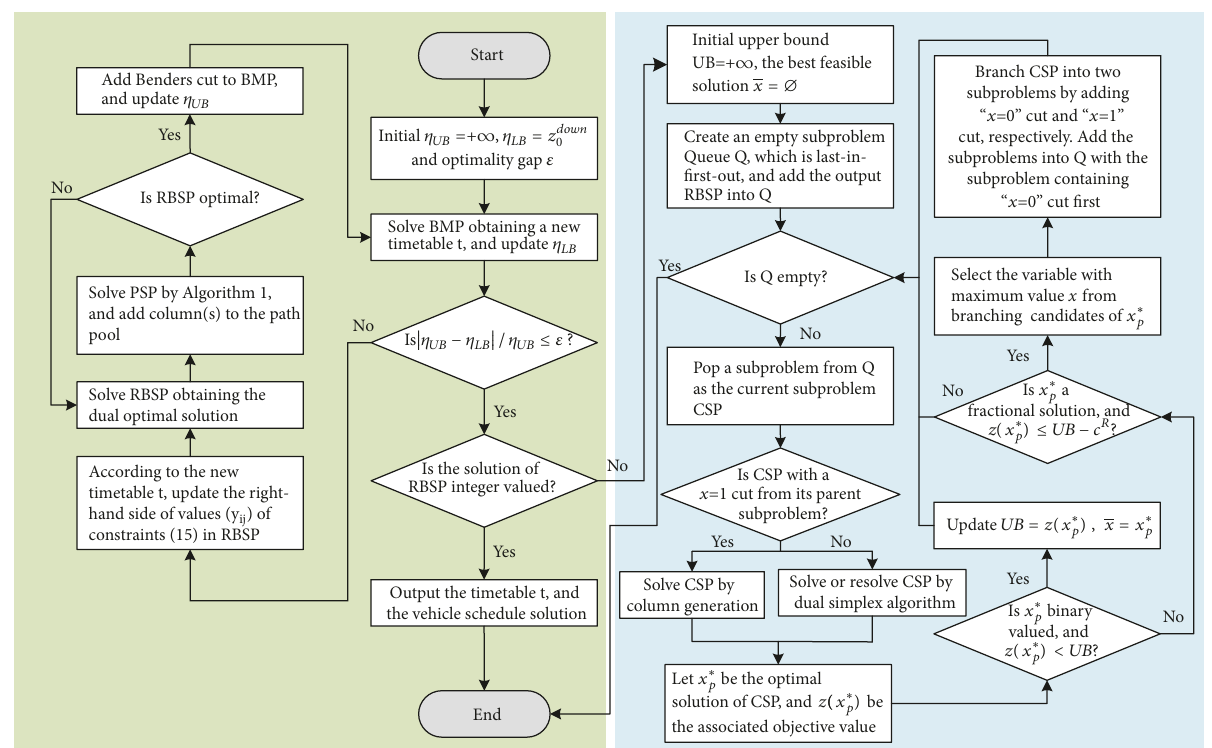
Figure 3: Flowchart of the overall